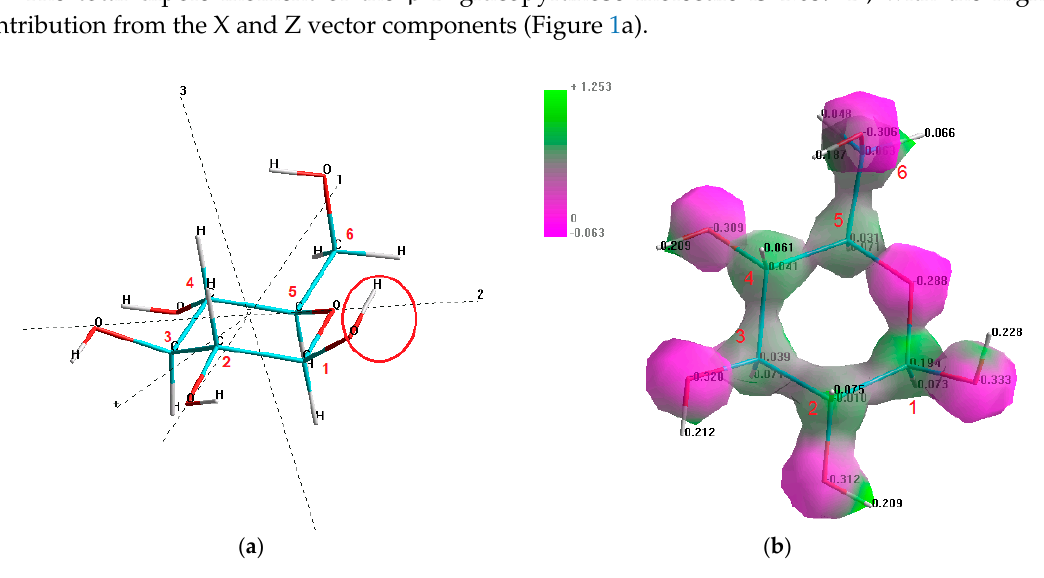
Figure 1. Molecular structure of β -D-glucopyranose with the numerated carbon atoms (based on their position in the structure): ( a ) The glycosidic hydroxyl group located at the C 1 atom (marked with the red oval); ( b ) electrostatic potential (e/a 0 ), mapped onto an isosurface of the total electron density of 0.13 e/a 03 (Notes: the numerator stands for the electron charge “e” (1.6022 × 10 − 19 coulombs), and the denominator is the first Bohr radius “a 0 ” (5.62918 × 10 − 11 m).).